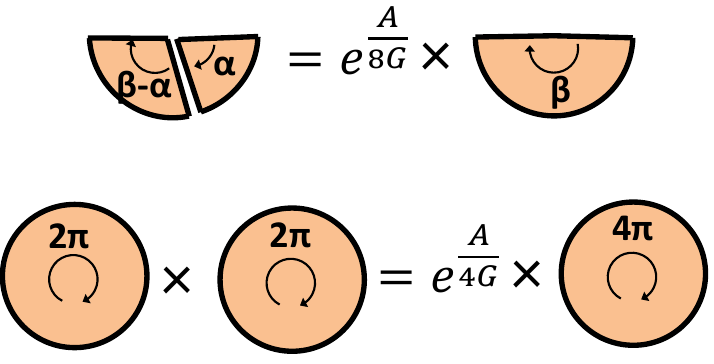
Figure 5 . Pasting two wave functions (Top) and its doubled version